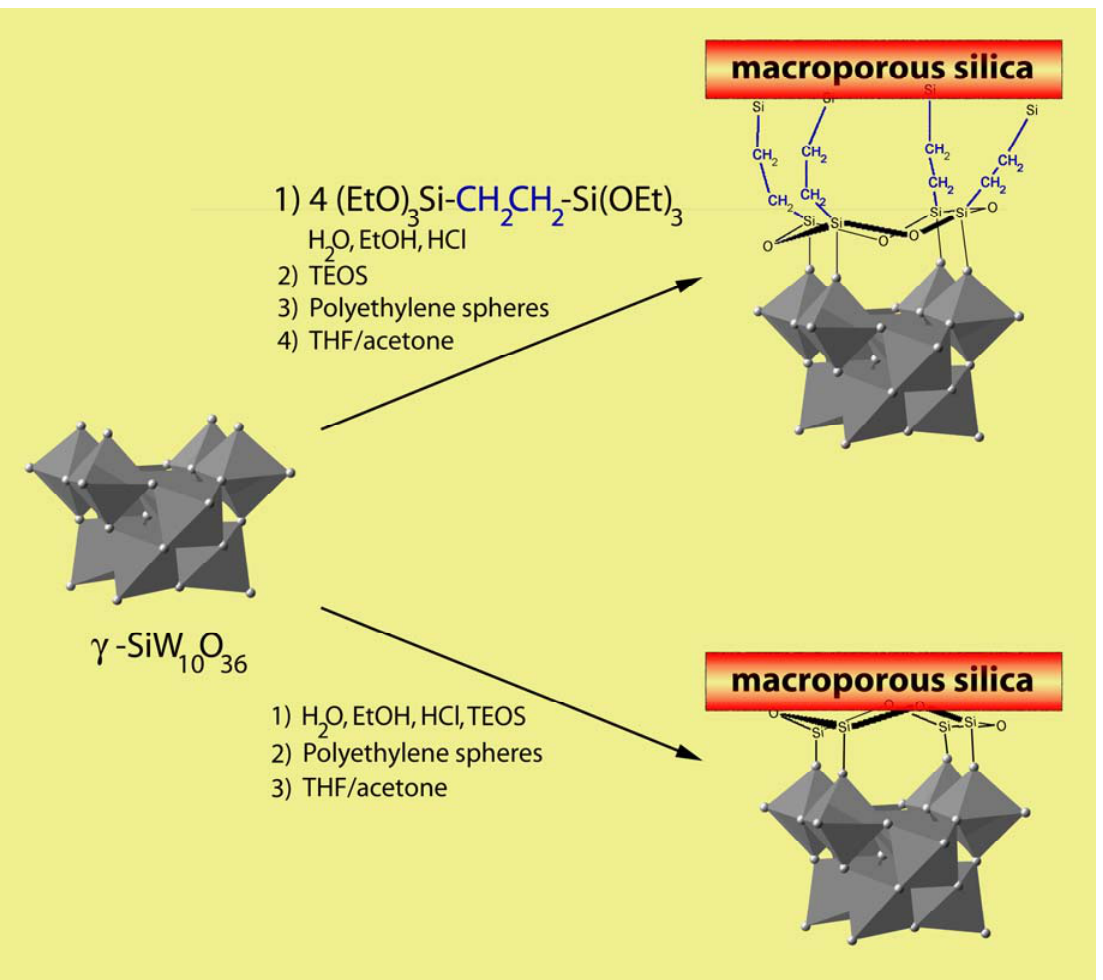
Figure 4. 3DOM silica functionalized with γ -tungstosilicate clusters of the type SiW O ] 4- [ γ -(RSiO) 4 10 36